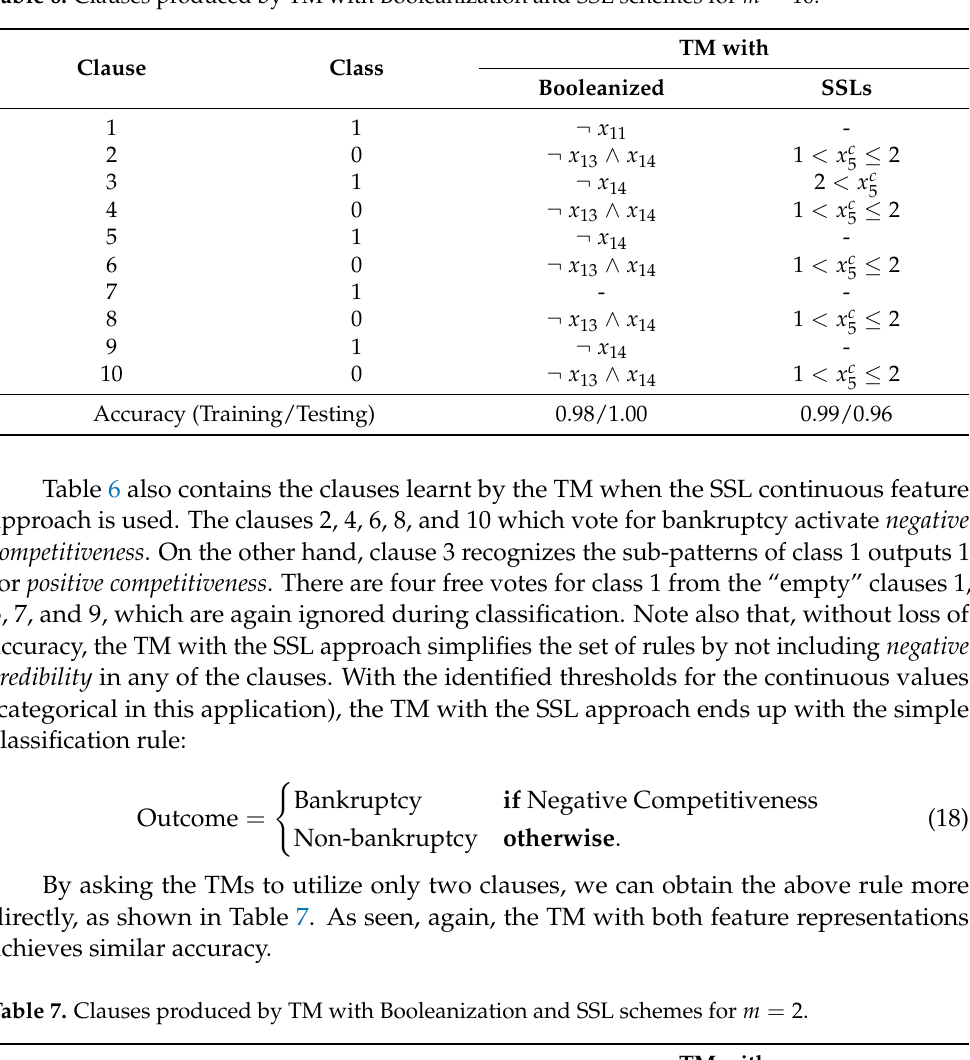
Table 6. Clauses produced by TM with Booleanization and SSL schemes for m = 10.